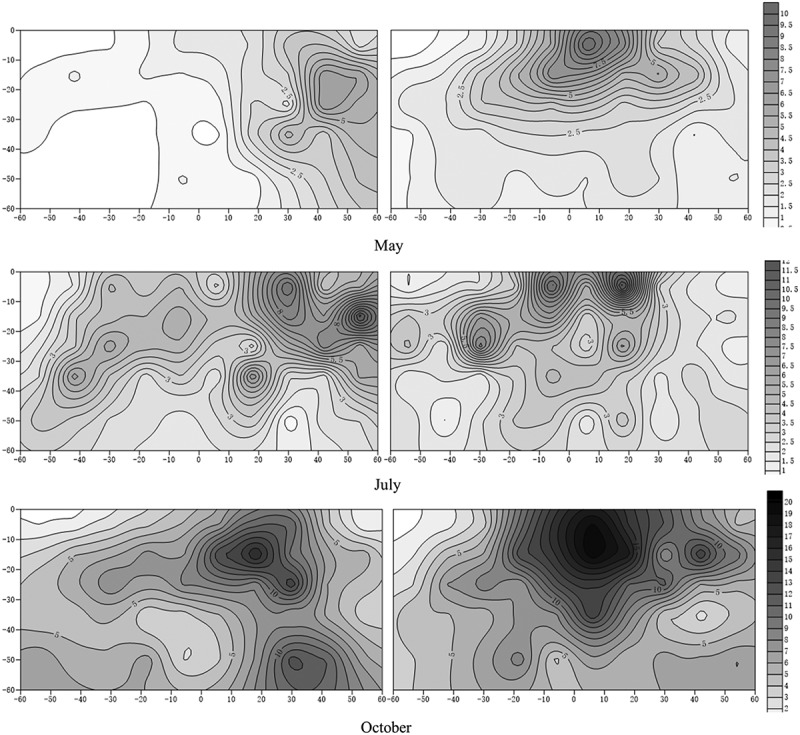
Isoline map of apple root distribution.1. Abscissa from −50 to 0 (under intercropping) is the area covered by white clover;2. The absolute value of the ordinate represents the depth of the soil layer;3. The coordinates (0, 0) are the planting positions of the apple tree